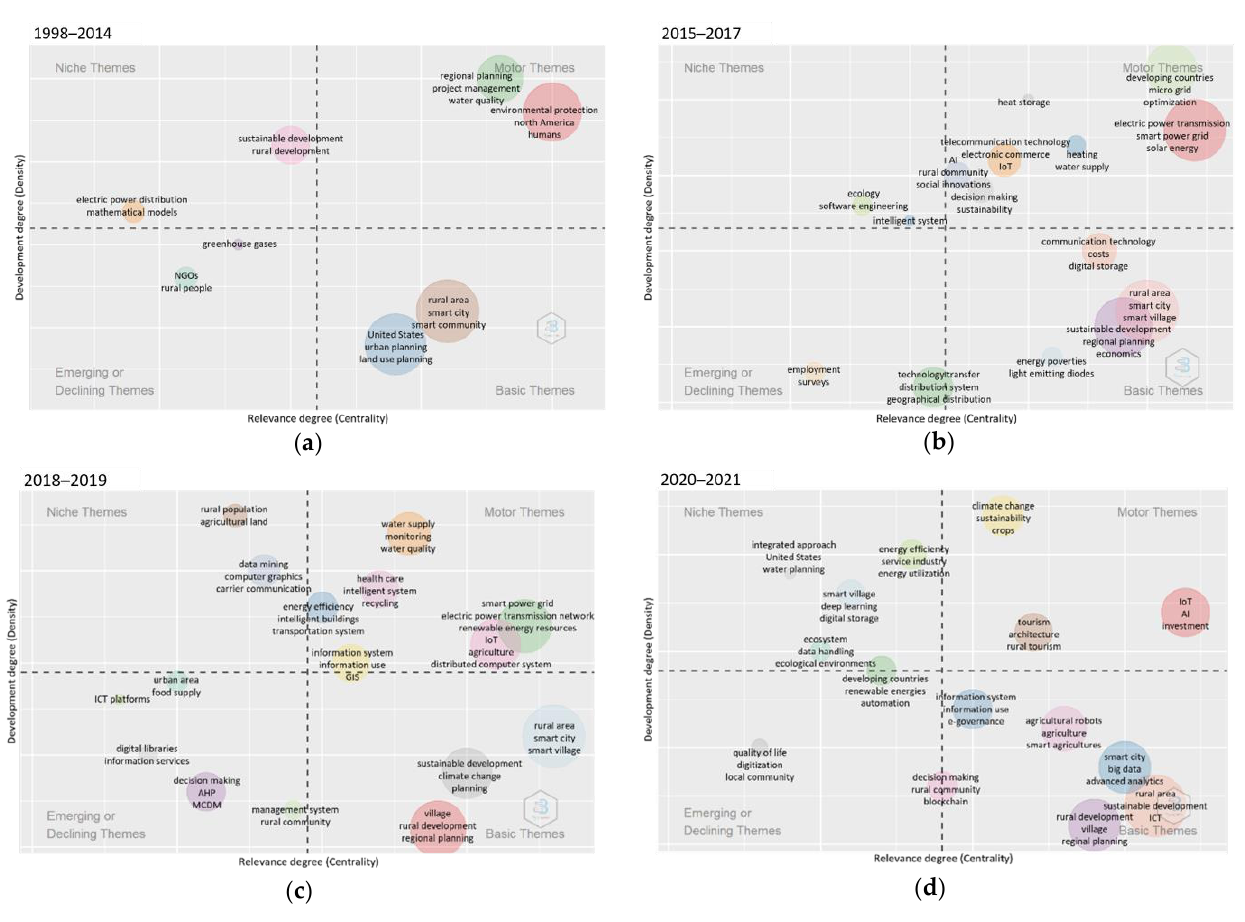
Figure 8. Strategic diagrams of smart village research (1998–2021). ( a ) 1998–2014 (41 documents);